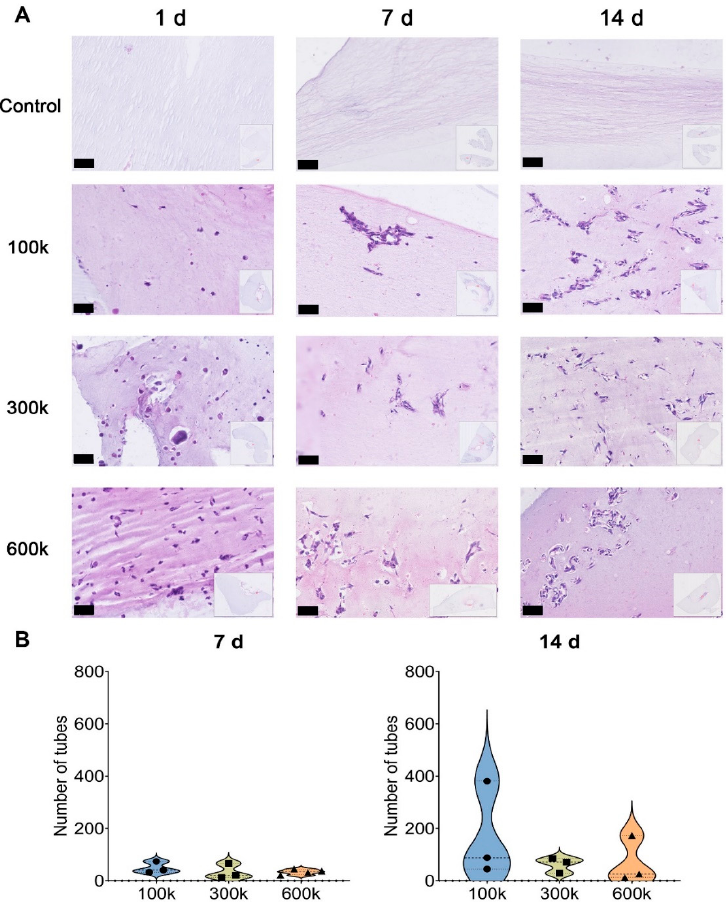
Figure 5. Histochemical analyses of VNF by HPMEC seeded in LV ECM hydrogels and stained by H&E. ( A ): 100 k, 300 k, and 600 k HPMEC seeded in LV ECM hydrogel were examined at days 1, 7, and 14 of culturing (original magnification was 40 × ) after H&E staining of thin sections. Bare hydrogels served as controls. Control hydrogels show the fiber-like meshwork of the LV ECM hydrogels. Cell-seeded hydrogels show clusters of cells (purple with dark-stained nuclei), often arranged as tubular structures. Insets show the entire section as scanned by the Hamamatsu image scanner. Scale bars represent 100 µ m. ( B ): quantification of the number of tubes (visible as cell clusters with a lumen) at days 7 and 14 ( n = 3, one way ANOVA comparing